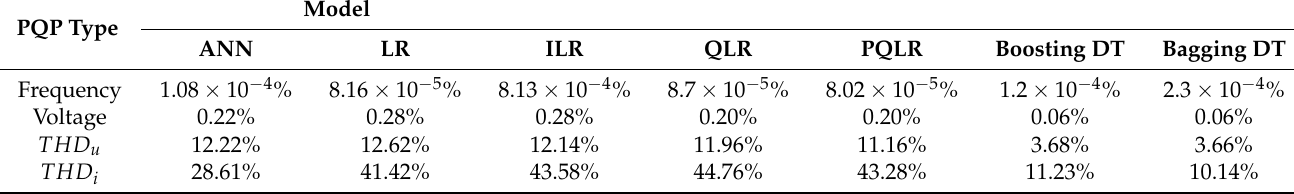
Table 14. Average error for 16–18 August 2021, obtained when using the ANN, LR, ILR, QLR, PQLR, the boosting DT, and the bagging